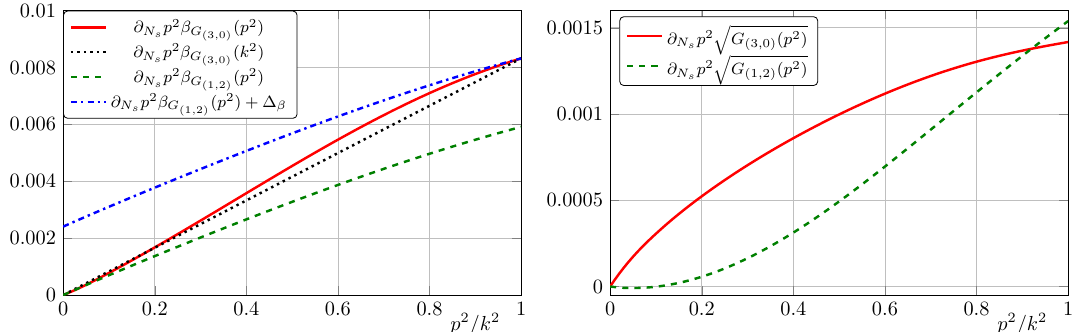
Figure 3: N -derivative of the momentum-dependent β -functions (left) and Newton s couplings (right) evaluated on the bilocal fixed point for N